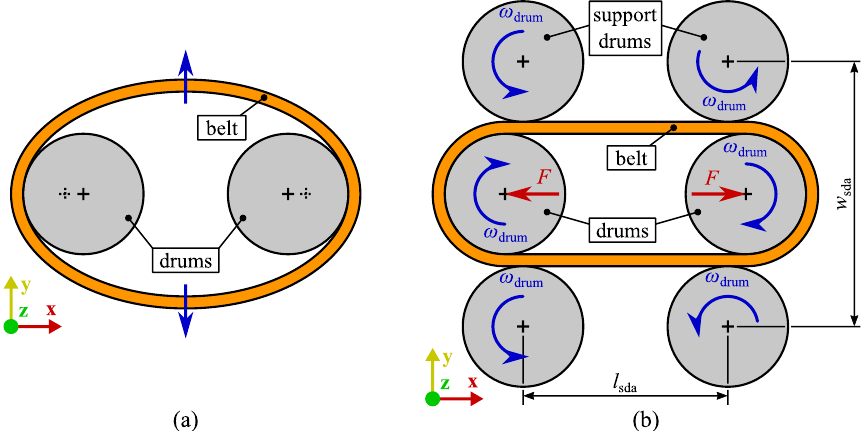
Figure 7. To avoid oscillations with belt deformations schematically shown in ( a ), four support drums are introduced ( b